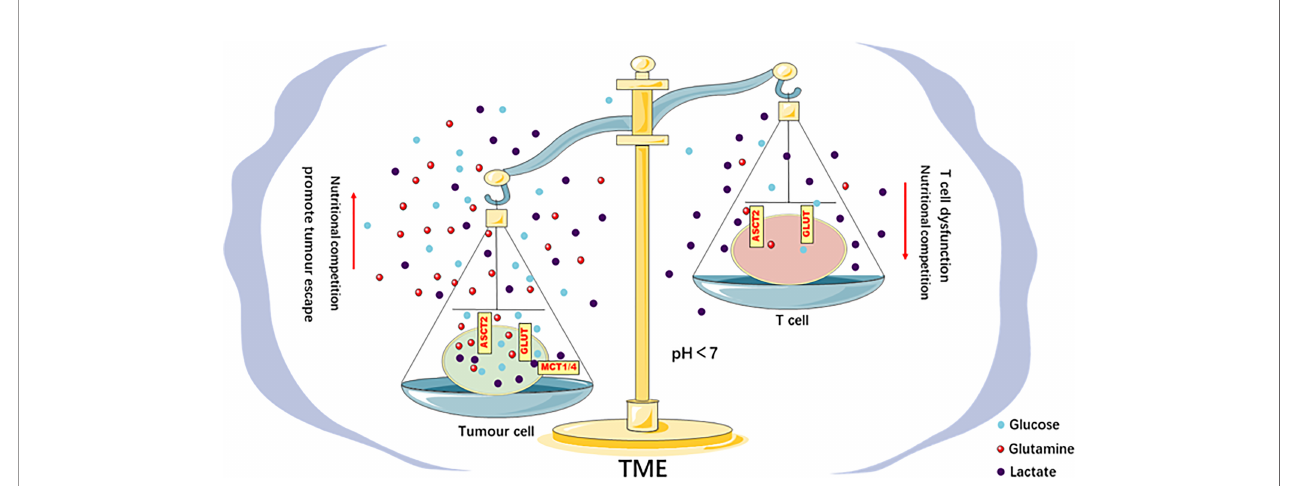
FIGURE 2 | Metabolic competition in the TME drives tumor progression. There is competition for glucose and glutamine between tumor and T eff cells in the TME. This competition leads to the limited use of energy materials by T eff cells and impairs their function, which promotes immune escape. The acidic TME caused by the lactic acid produced by the tumor Warburg effect inhibits the function of T eff cells, impairs the antitumor immune response, and promotes tumor